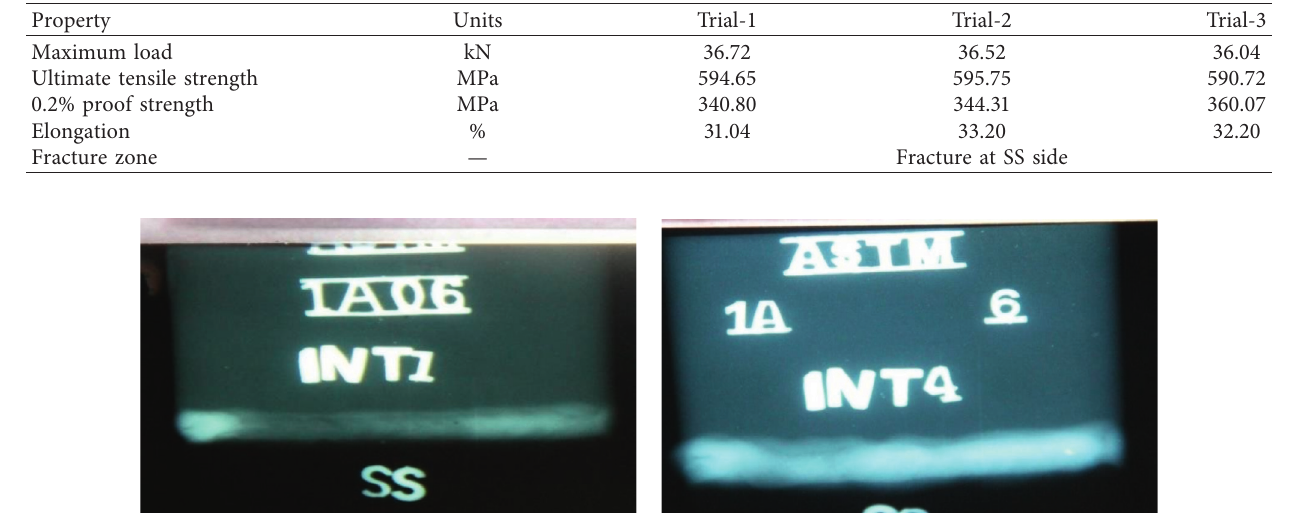
Table 3: Tensile strength properties of dissimilar weldments of INCONEL625 and